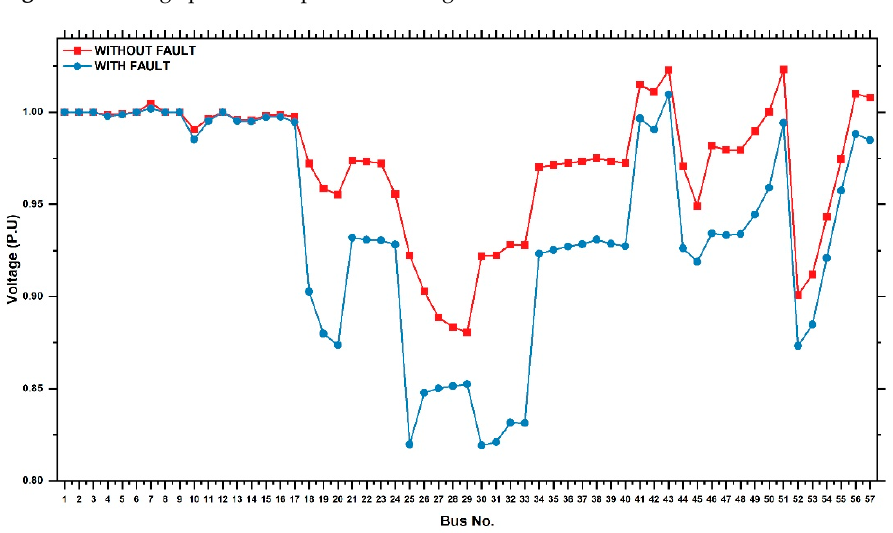
Figure 18. Fault generation in the electrical system.